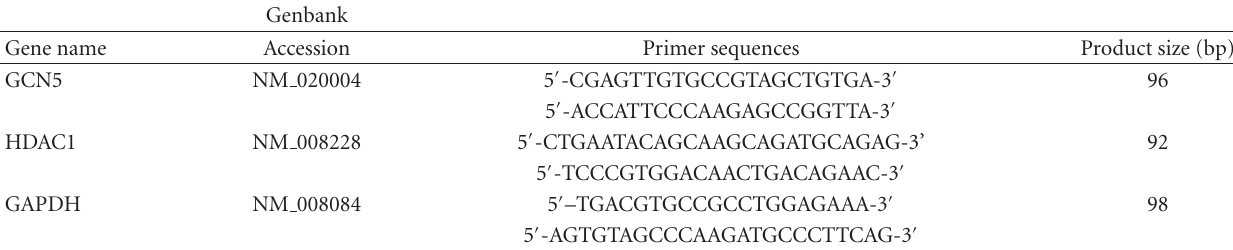
Table 1: Reference genes selected for the study, and sizes of the PCR